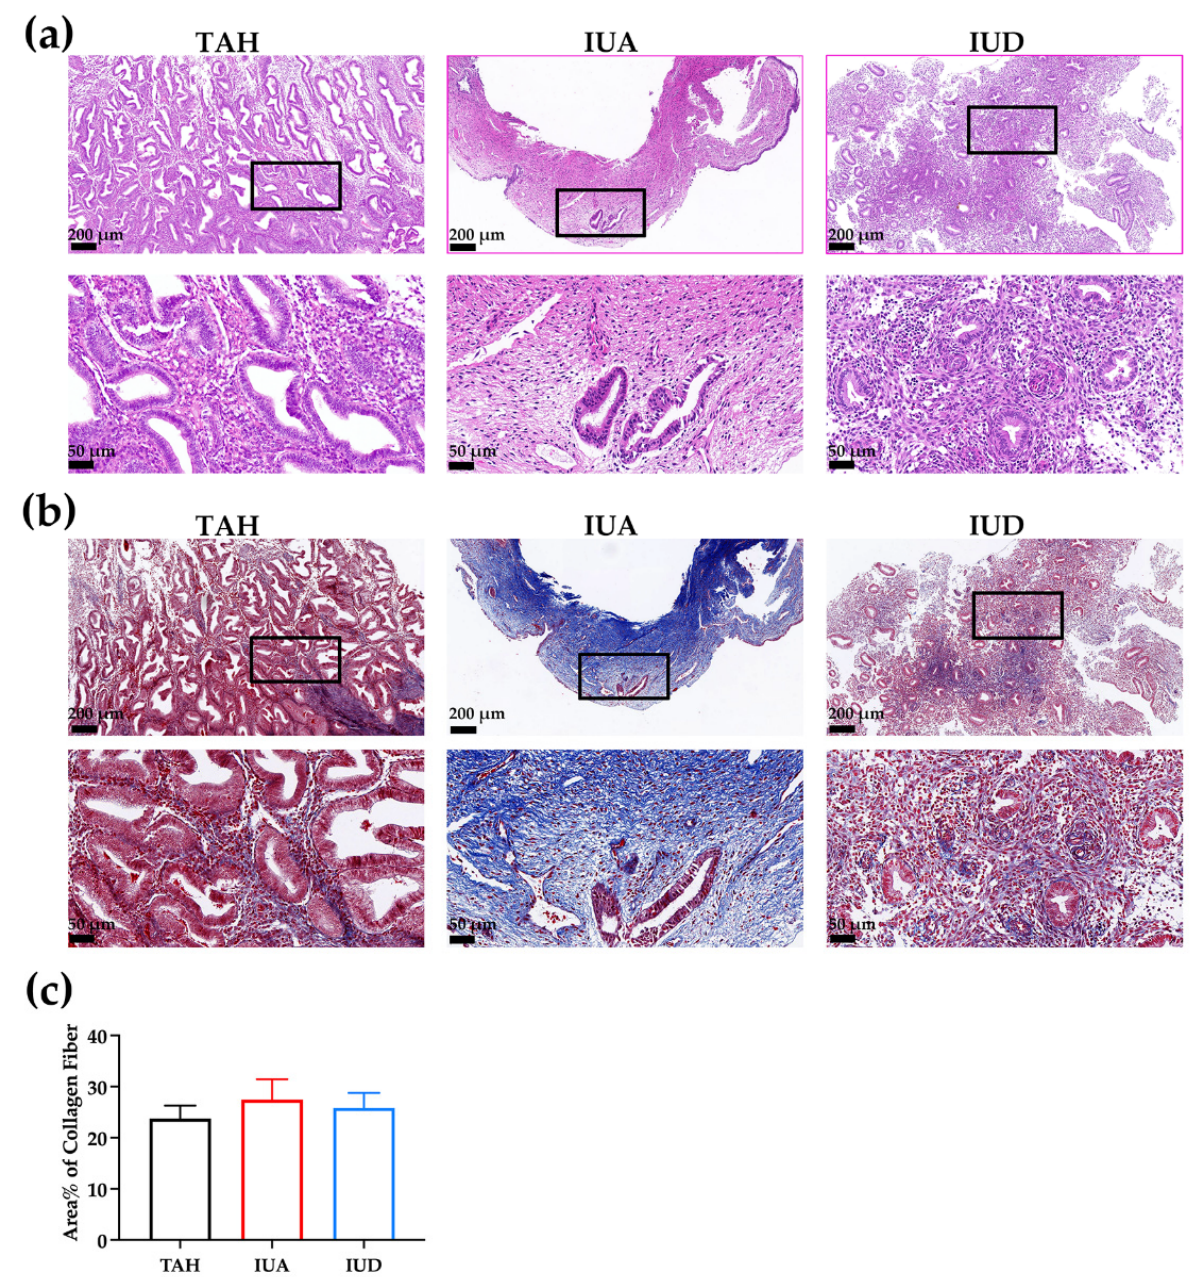
Figure 1. Sections of endometria from TAH, IUA and IUD of patients who received TCRA within the past three months were stained with H&E ( a ) and Masson trichrome staining ( b ). ( c ) Area% of collagen fiber based on the Masson trichrome staining is presented in bars. Magnified areas are marked in black boxes. Scale bar, 200 µ m (top) and 50 µ m (bottom/magnified). Data are expressed as mean ± SEM, ( n =